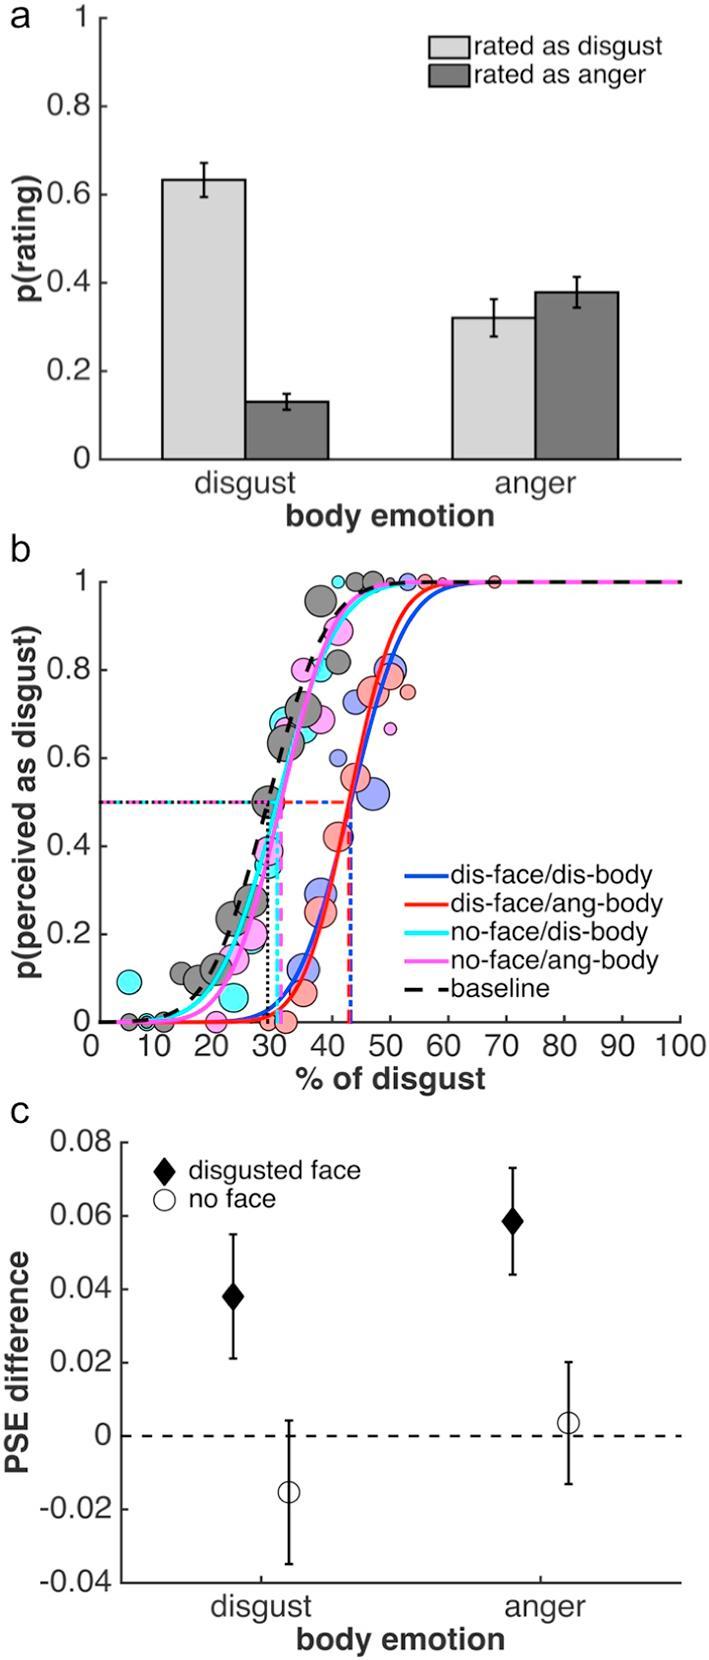
Results of Study 1. Facial expressions in this study always showed disgust. (a) Mean proportion of perceptual categorizations as disgusted or angry in response to a disgusted facial expression in a disgusted or angry body context. (b) Psychometric functions from one example observer to illustrate the results of the adaptation task. Dotted lines indicate PSEs, the size of the circles illustrates the number of trials for a given morph level. As can be seen, there is no difference between the baseline PSE and PSEs after adaptation to body contexts alone. Adaptation to a disgusted face generates aftereffects, as indicated by the difference of the respective PSEs to baseline. These aftereffects are independent of body context and consistent with adaptation to disgust. (c) Facial expression aftereffects plotted as the mean difference between the baseline PSE and PSEs after adaptation to face-body stimuli, for a disgusted facial expression with a disgusted or angry body (diamonds), and for the two body contexts without faces (circles). Error bars denote ±1 SEM in all plots.